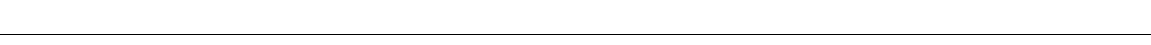
Fig. 4 Distance-dependent inhibition boosts focal PING oscillations and PN spike timing. a – d Local rhythmic activity is induced by focal stimulation of a subgroup of only PNs in networks with different strengths ( g EI ) of feedback excitatory synapses to INs (PN – IN). Top, schematic of the circuit. Bottom, raster plots showing the activity in the IN (noDD: black; DD: red) and PN (gray) population before and after stimulus onset at t = 100 ms for 100 ≤ t < 500 ms. e – h Central network activity for different g EI values. Black (noDD) and red (DD) continuous lines and shaded areas indicate means ± SD for 10 simulation runs. Dashed lines indicate means of 10 simulations in chimeric DD networks with distance dependence only in either IN – IN (DD II, orange) or IN – PN synapses (DD IE, purple). e Dominant oscillation frequency and corresponding power of mean momentary IN and PN fi ring rates. f Average fi ring rates of INs and PNs. g Dominant oscillation frequency and corresponding power of the recorded LFP-A. h Mean coupling strength of IN and PN spikes to the LFP-A. Note that for g EI = 0 mS cm − 2 , the network generates ING oscillations. With increasing feedback excitation, the network switches to PING, corresponding to a drop in the oscillation frequency ( g , right; see also schematic in e , top left). Statistical analysis compares noDD and DD networks. i Average properties of focal oscillations in noDD, DD and the chimeric DD II and DD IE networks. To elicit ING oscillations, PN – IN feedback was switched off and both INs and PNs received focal stimulation (cf. Fig. 3b). Top, dominant oscillation frequency and corresponding power of LFP-A of the central network. Bottom, focal IN and PN coupling to the LFP-A. j Analysis of focal gamma activity resulting from PING-based synchronization, corresponding to i . Networks contained PN – IN feedback ( g EI = 0.1 mS cm − 2 ) and only PNs received the focal excitation. Bars and error bars indicate mean and SD of 10 simulation runs. Statistical analysis compares all three DD networks to the noDD circuit. * p < 0.05; ** p < 0.01; # p < 0.001; two-tailed, two-sample t